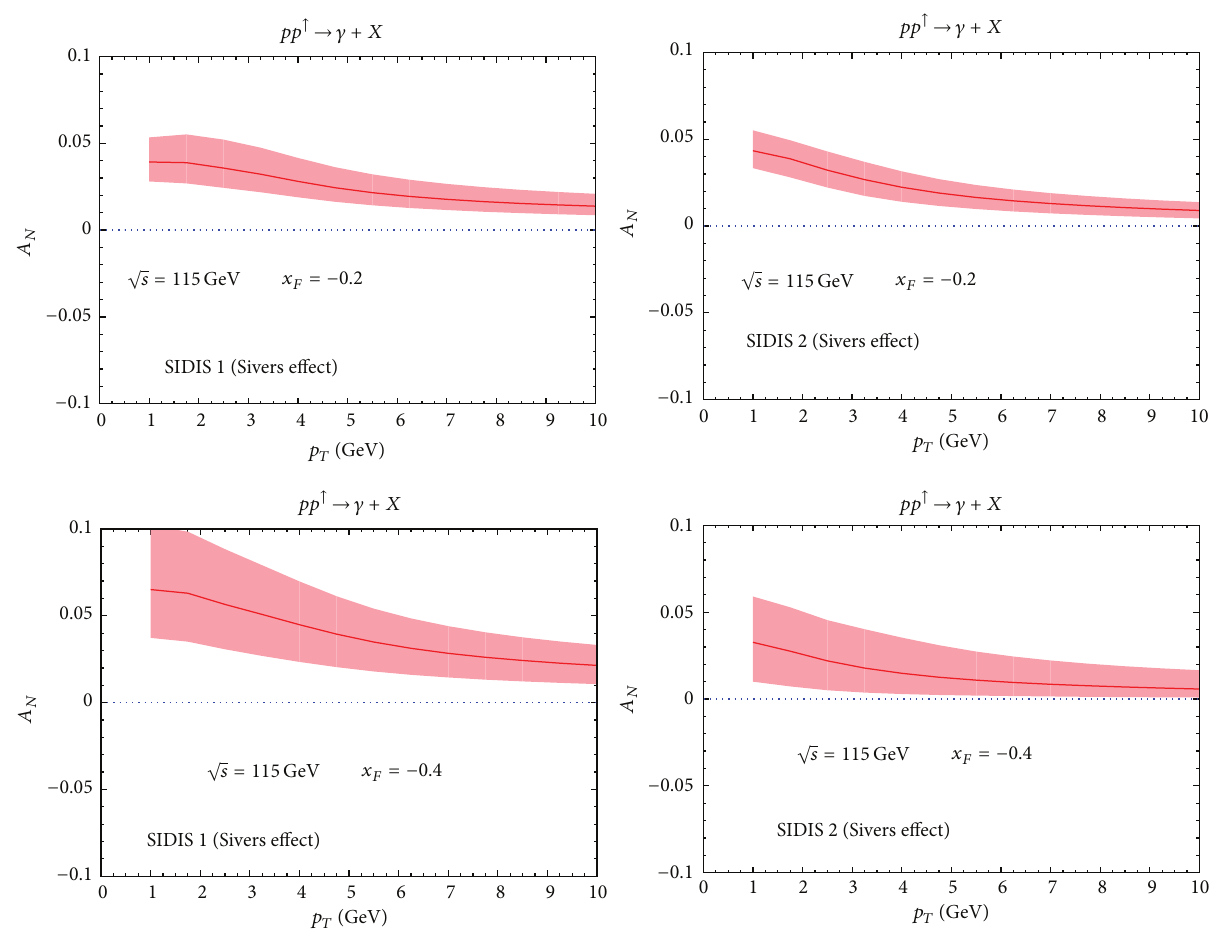
Figure 4: Our theoretical estimates for 𝐴 𝑁 versus 𝑝 𝑇 at √𝑠 = 115 GeV, 𝑥 𝐹 = − 0 . 2 (upper plots), and 𝑥 𝐹 = − 0 . 4 (lower plots) for inclusive photonproductionin 𝑝𝑝 ↑ → 𝛾𝑋 processes,computedaccordingto(6)and(7)ofthetext.OnlytheSiverseffectcontributes.Thecomputation is performed adopting the Sivers functions of [20] (SIDIS 1, left panels) and of [21] (SIDIS 2, right panels). The overall statistical uncertainty band, also shown, is obtained following the procedure described in Appendix A of